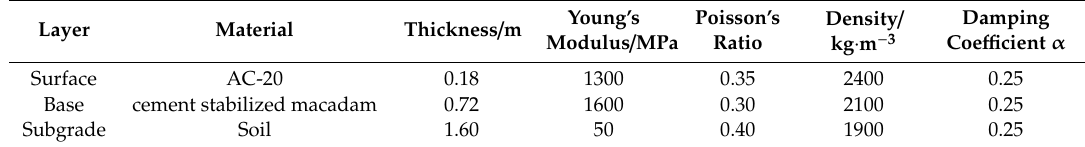
Table 1. The model dimensions are as follows: length × width × thickness = 10 m × 6 m × 2.5 m. Table 1. Geometry and material parameters of the pavement Table 1. Geometry and material parameters of the pavement model.